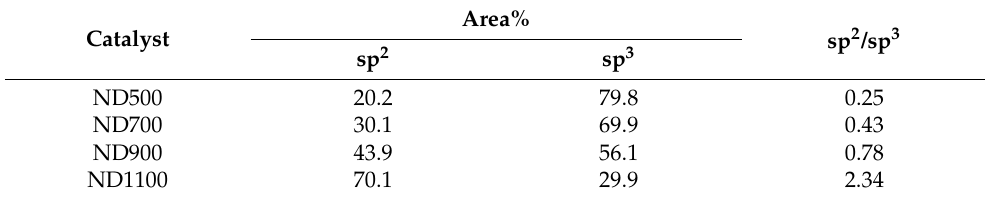
Table 2. The sp 2 /sp 3 data of the samples based on XPS.